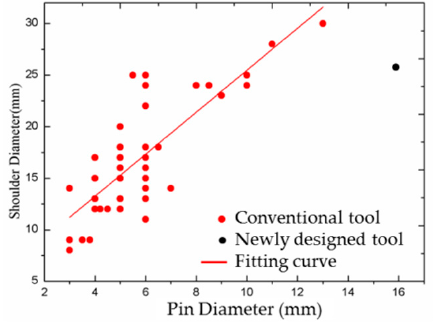
Figure 4. Comparison of the tool diameters distribution.